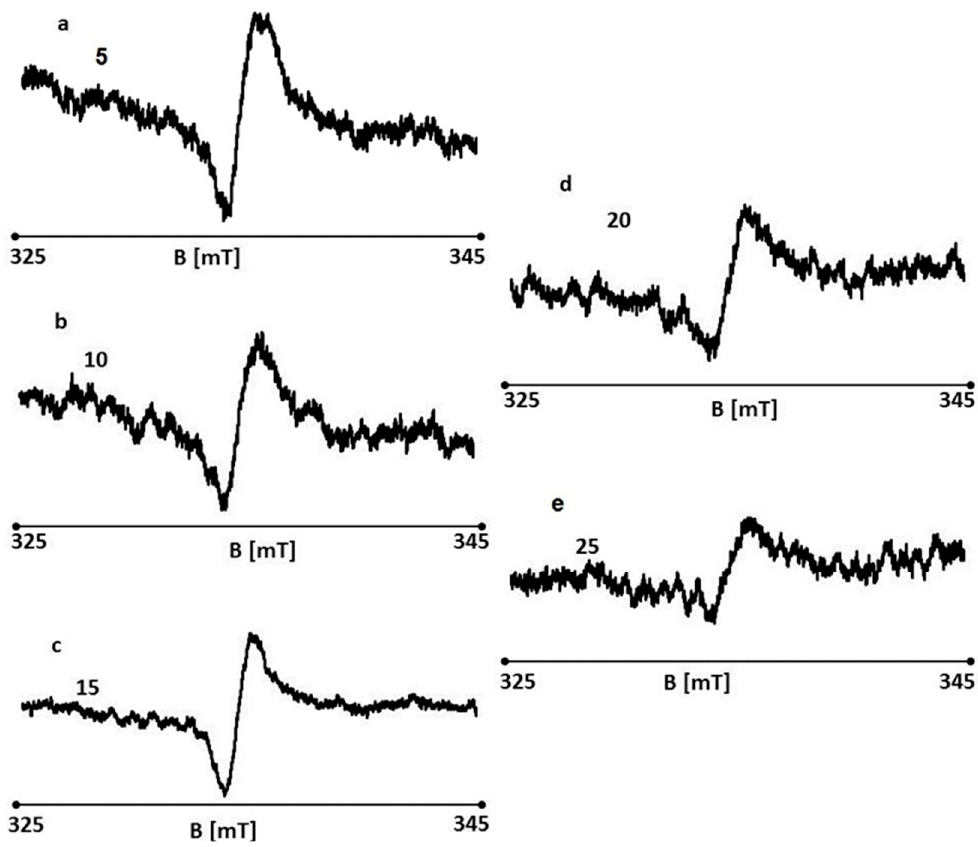
Figure 29. EPR spectra of burn wounds treated with the 1% propolis ointment on days 5 ( a ), 10 ( b ), 15 ( c ), 20 ( d ), and 25 ( e ) of the treatment.